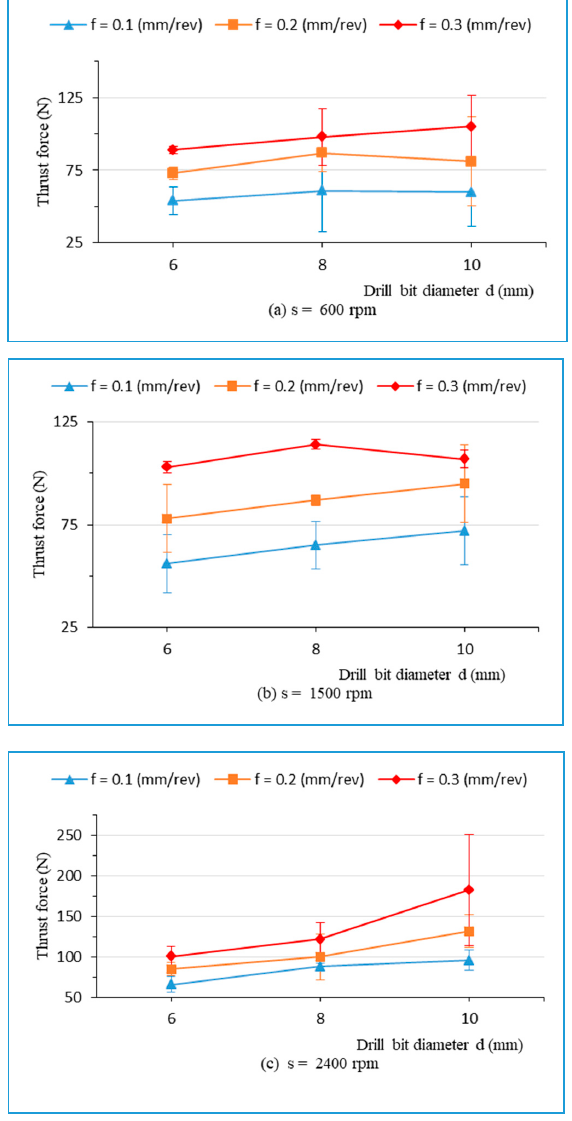
Figure 4. Thrust force related to drill bit diameter during drilling of hybrid biocomposite with different feed rates, at spindle speeds: ( a ) s = 600 rpm, ( b ) s = 1500 rpm, and ( c ) s = 2400 rpm.